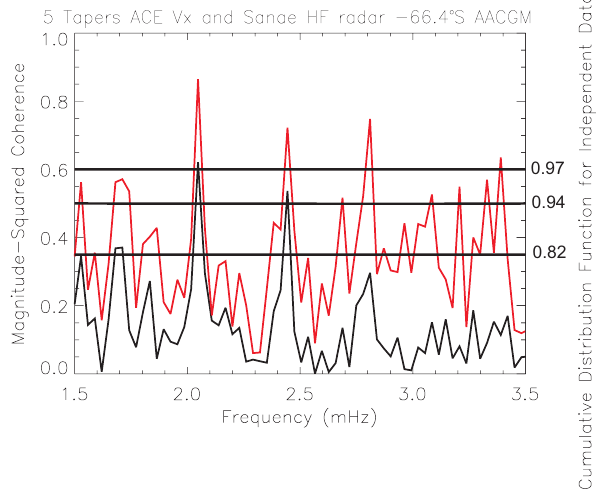
Fig. 9. Phase coherence between ACE Vx and radar Doppler ve- locity parameters. Cross-phase (phase difference) is plotted as solid line. Red curves are one jack-knife standard deviation on either side of the phase coherence.